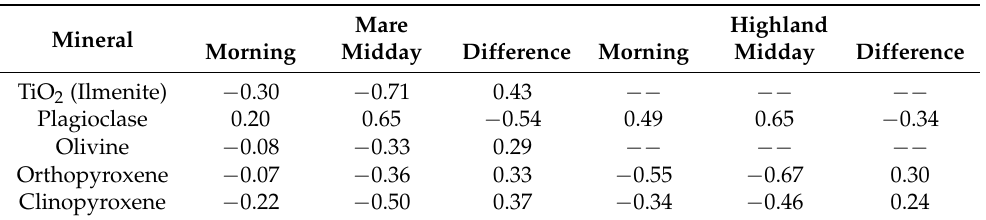
Table 1. Correlation coefficients r for the dependence of OHIBD on the abundances of the major minerals on the surface of the Moon.